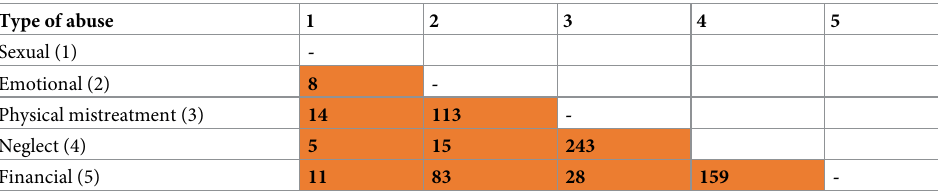
reported their perpetrators to the police. The factors significant at bivariate analysis were tested